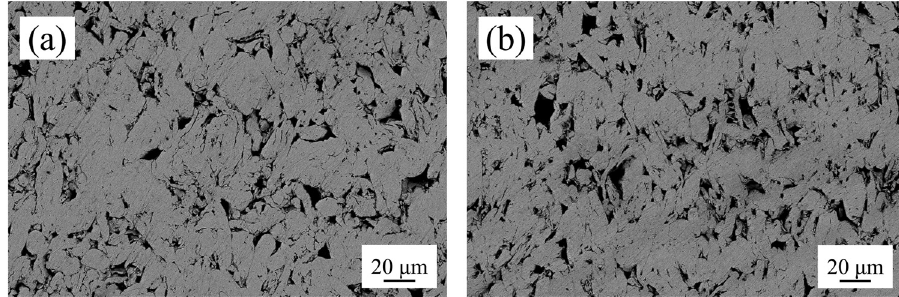
Figure 4: BSD morphology of sintered samples by ( a ) raw powder and ( b ) milled